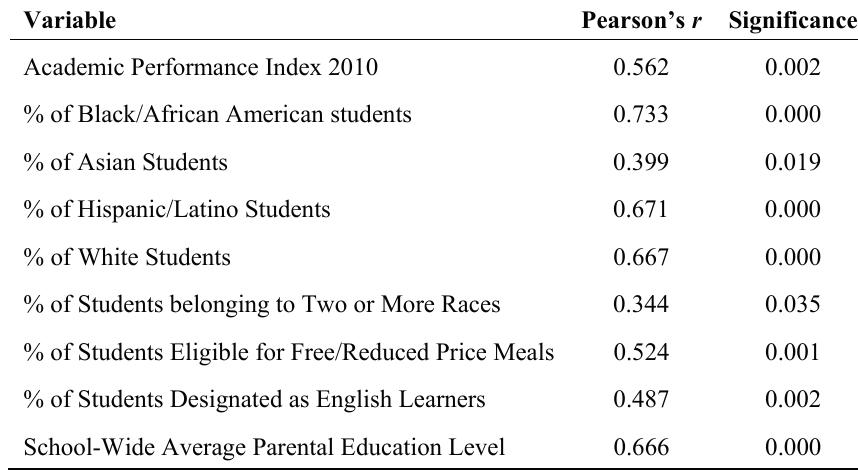
Table 2. Correlation between student characteristics of largest school (by enrollment) vs. smaller schools in parcels with two schools; N = 38 for each